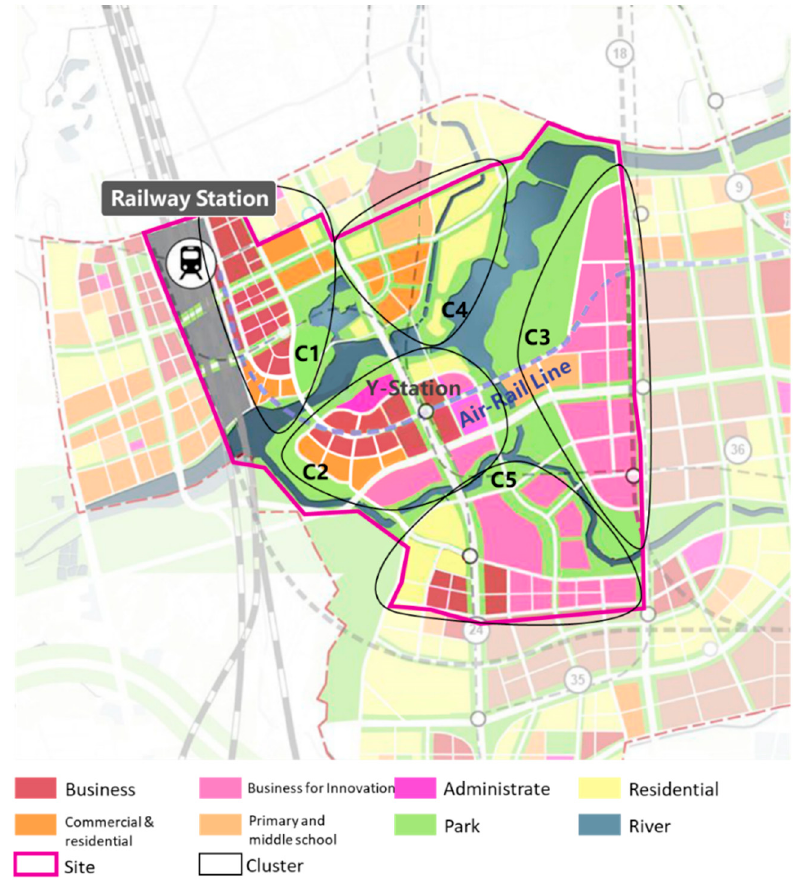
Figure 14. The detailed plan of the air–rail integration zone project (five clusters near rivers and main roads; cluster 1–3 along the air–rail line, mainly consisting of business, business for innovation, and commercial and residential areas; cluster 4 north of cluster 1–3, consisting of residential areas and other amenities; and cluster 5 south of cluster 2–3, consisting of business, business for innovation and residential areas). Table 2. Restrictions and requirements in air–rail line